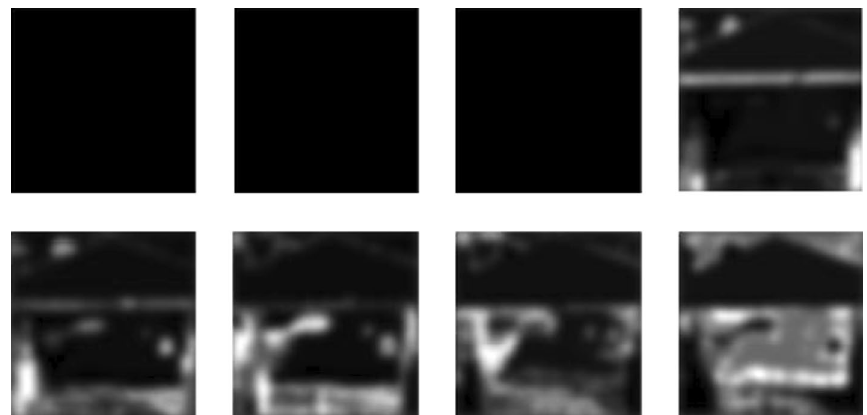
Fig. 6 Each feature layer of the small target after the second convolution